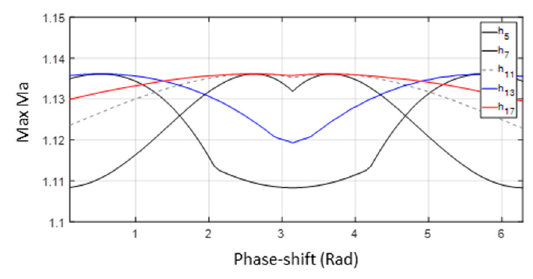
Figure 10. Maximum modulation index (Max Ma: inverter voltage) for a B = 40% and h = 5th, 7th, 11th, 13th and 17th voltage harmonics for a PWM modulation with a 3rd harmonic. Maximum modulation index value for all possible phase shifts ( β = 0–2 π ).